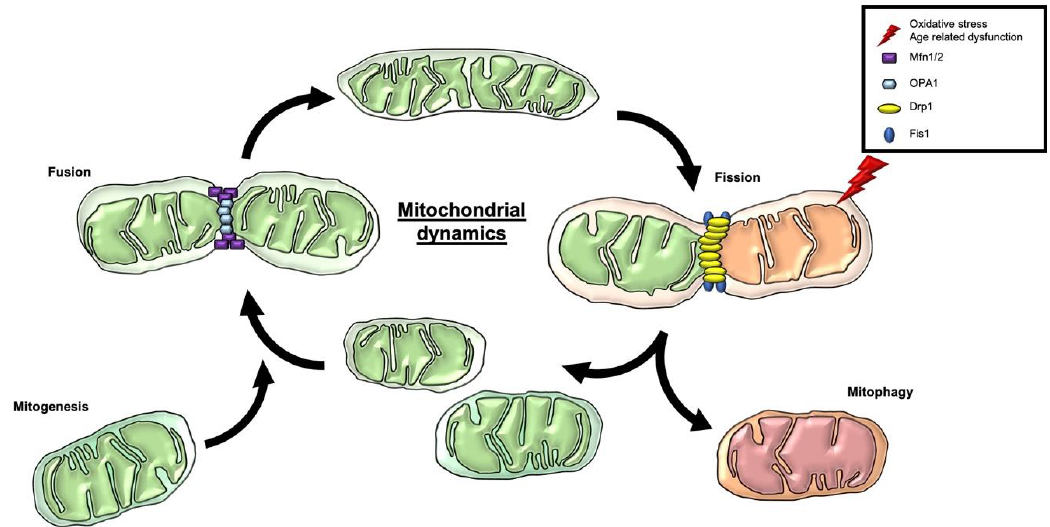
Figure 2. Mitochondrial dynamics, mitogenesis, and mitophagy as mitochondrial quality control.